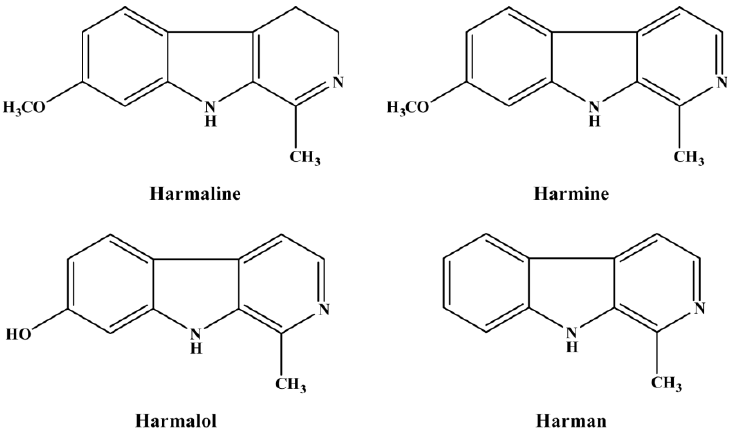
Figure 1. Molecular structural formulas off our isolated alkaloids (harmaline, harmine, harmalol, and harman) from Peganum harmala seeds.